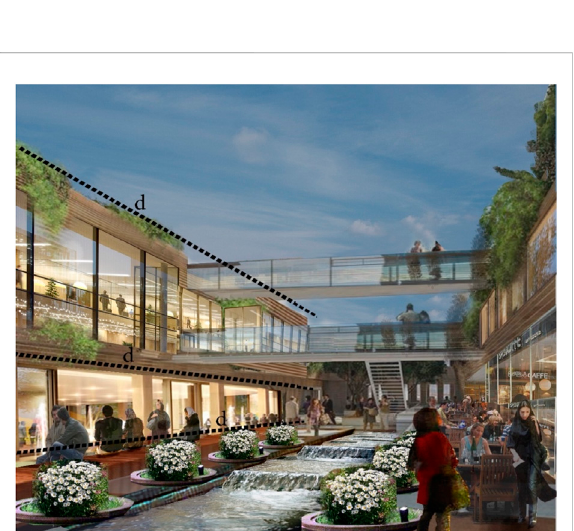
FIGURE 3 Photo on Card one shows Attribute “ water ” with “ stream ” level, attribute “ plant ” with “ horizontal ” level, attribute “ facade orientation ” with “ horizontal ” level, and attribute “ shape ” with “ straight ” level, attribute “ solid/void ” with “ no void ” level, attribute “ material ” with “ transparent ” level, and attribute “ dimension (height) ” with “ medium ” level.